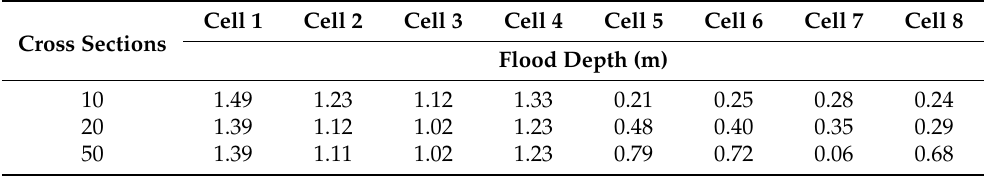
Table 3. Maximum flood depth values in different cells for certain cross sections in sub-reach